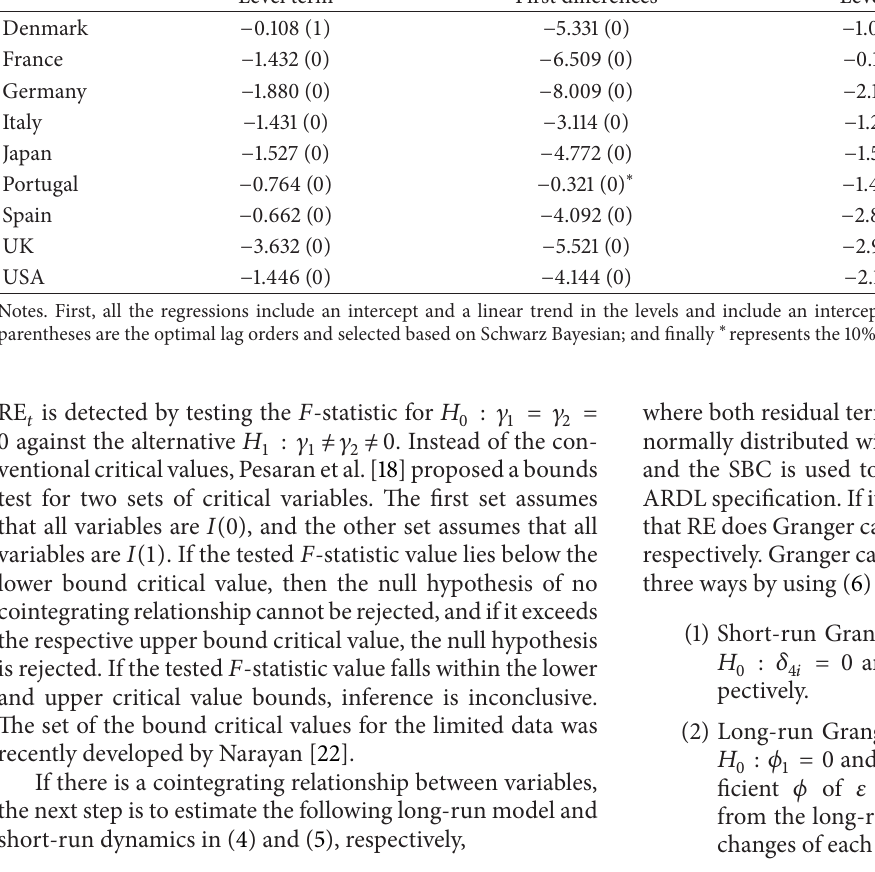
Table 1: ADF unit root test results.